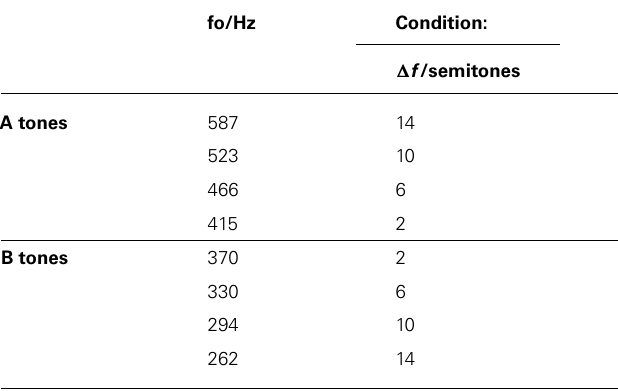
Table 2 | Median fundamental frequencies fo of theA and B tone complexes in the different (cid:2) f conditions. fo/Hz Condition: (cid:2) f